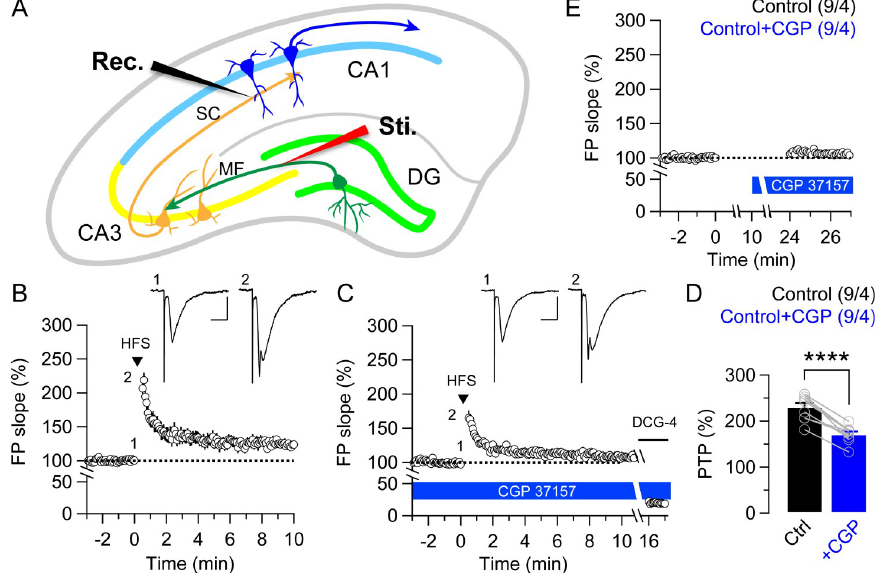
Fig 3. Inhibition of mitochondrial Ca 2+ release reduces PTP at SC synapses by disynaptic MF stimulation. ( A ) A Schematic representation of a hippocampus showing the electrode location for stimulating (Sti.) MF synaptic input and recording fEPSPs (Rec.) in the stratum radiatum . ( B & C ) The magnitude of PTP induced by HFS is substantially less at SC synapses after 15 min treatment of CGP37157 (20 μ M). The insets represent traces recorded before and immediately after HFS. Scale bar: 15 ms, 0.5 mV. DCG-4 (2 μ M) was applied at the end of each experiment to confirm that MFs were stimulated. ( D ) Bar graphs show the mean magnitude of disynaptic PTP inductions before and after CGP37157 application (Control: 230.4 ± 8.7%; +CGP: 171.7 ± 5.8%; p < 0.0001, paired t -test). ( E ) The effects of CGP37157 treatment on basal transmission. The magnitude of basal transmission is similar in the absence or presence of CGP37157. All data are mean ± SEM ( ���� p < 0.0001; Student’s t -test). The value in parentheses indicates the number of hippocampal slices (left) and the number of mice (right) used in each